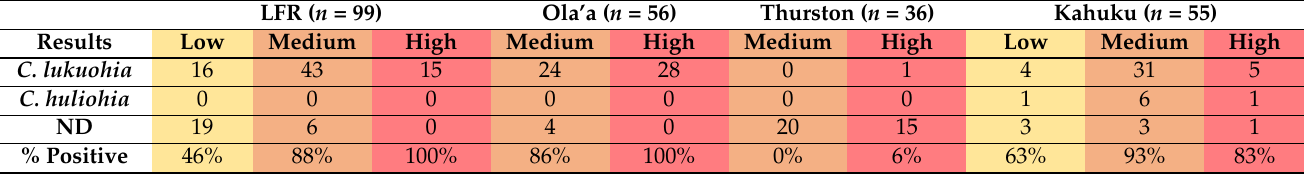
Table 2. Laboratory results for suspect trees sampled across the four study sites grouped by confidence ratings.